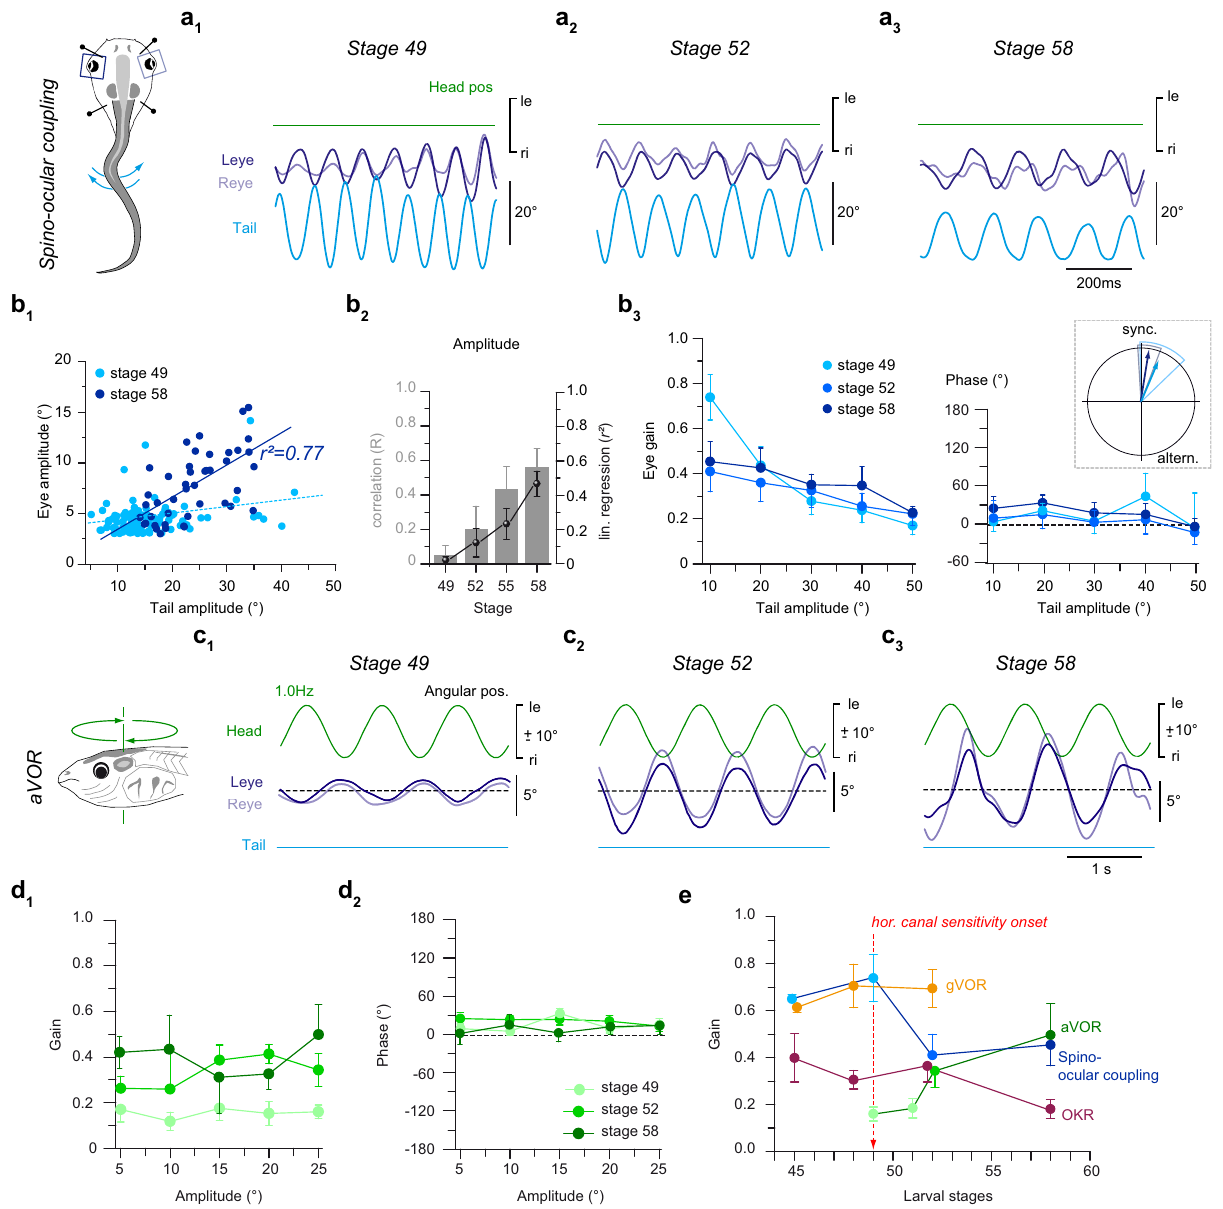
00.20.40.60.81.0 Fig. 2 Developmental improvement of swim-related predictive ocular motor behavior and horizontal angular vestibulo-ocular re fl ex performance. a Movement of the left (Leye) and right eye (Reye), triggered by spino-ocular motor coupling (pictogram) at stage 49 ( a 1 ), 52 ( a 2 ) and 58 ( a 3 ) during undulatory tail movements. b Quanti fi cation of spino-ocular motor coupling parameters, presented as scatter plot of eye motion amplitudes relative to tail motion amplitudes ( b 1 ), histogram (gray bars) of the correlation coef fi cient ( R ) and linear (lin.) regressions ( r ² , black spheres) between stage 49 and 58 ( b 2 , stage 49: N = 8, stage 52: N = 6, stage 55: N = 7, stage 58: N = 9), linearity analysis of the eye position gain (left in b 3 , stage 49: N = 8, stage 52: N = 5, stage 58: N = 7) and phase (right in b N = 10, stage 52: N = 4, stage 58: N = 6) as function of the tail undulation amplitude for three 3 , stage 49: representative stages (see color-code); data are presented as mean values± SEM. The inset illustrates a polar plot of the average phase relation (mean ± 95% con fi dence intervals; detailed polar plots shown in Supplementary Fig. 2d, e) at stage 49 and stage 58. c Angular vestibulo-ocular re fl ex (aVOR), elicited by sinusoidal horizontal head rotation (pictogram) at 1 Hz and ±10° positional excursions at stage 49 ( c 1 ), 52 ( c 2 ) and 58 ( c 3 ) in the absence of swim-related tail undulations (light blue line) in darkness. d Linearity analysis of the aVOR gain ( d 1 ) and phase ( d 2 ) plotted as function of the head motion amplitude for three representative stages (see color-code; stage 49: N = 4, stage 52: N = 5, stage 58: N = 5) during sinusoidal rotations at 1 Hz (mean ± SEM). e Summary plot of the eye position gain (mean ± SEM) as index for the pro fi ciency of spino-ocular motor coupling, aVOR, OKR and gVOR during larval development from stage 45 to stage 58. Numbers of animals (N) used in this plot were equivalent to the numbers of animals employed in Supplementary Figs. 1d, e and 2b 3 – d 1 at different developmental stages. le, ri, leftward, rightward movement. Source data are provided as a Source Data fi